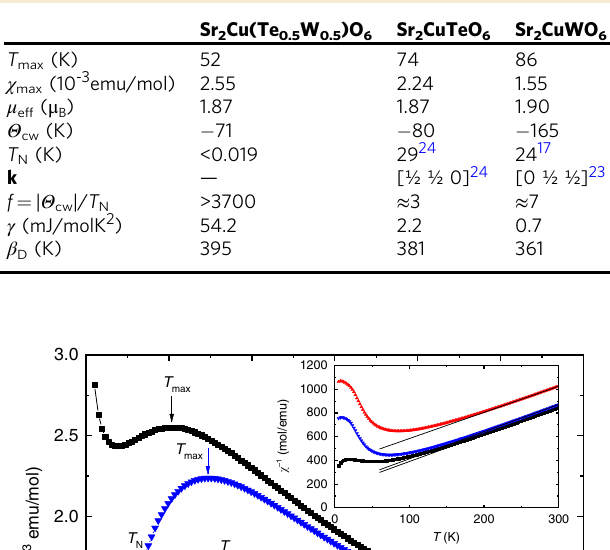
Table 1 Magnetic and thermodynamic properties of